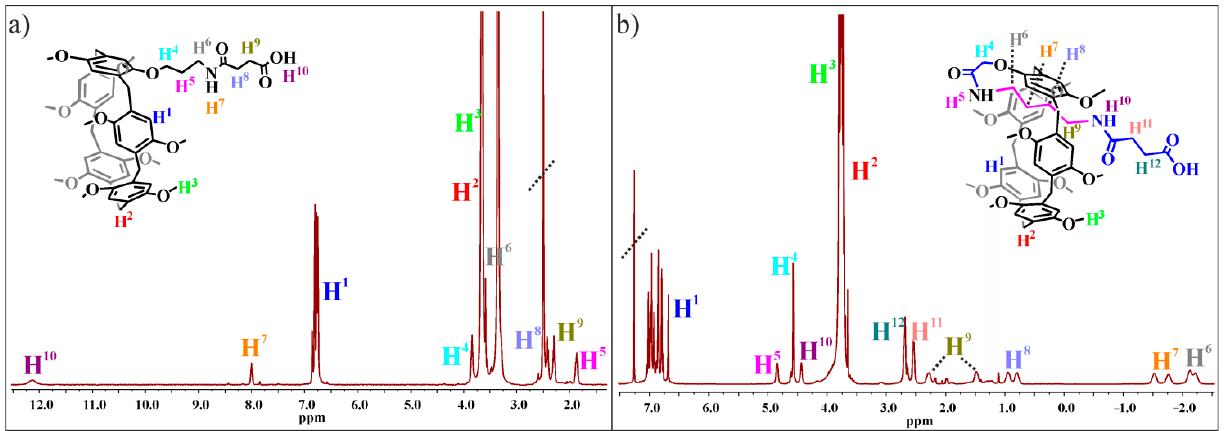
Figure 1. 1 H NMR spectra of: ( a ) the macrocycle 4 (DMSO- d 6 , 400 MHz, 293 K); ( b ) the macrocycle 5 (CDCl 3 , 400 MHz, 298 K).